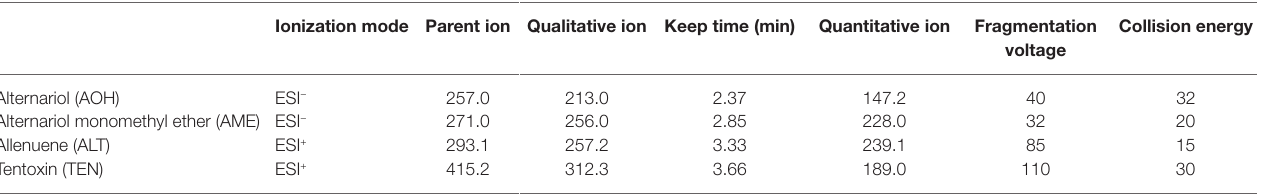
TABLE 3 | Optimized multiple reaction monitoring (MRM) parameters of the mycotoxins.